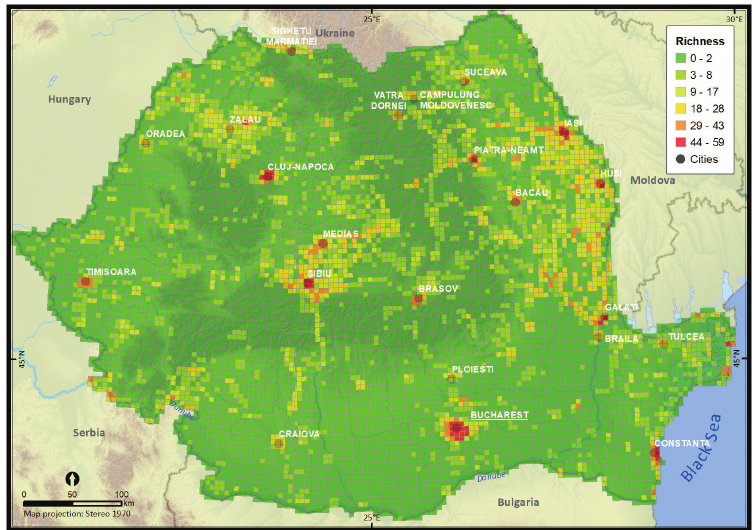
Figure 5. Invasive and potentially invasive alien plant species richness in Romania (5 × 5 km grid